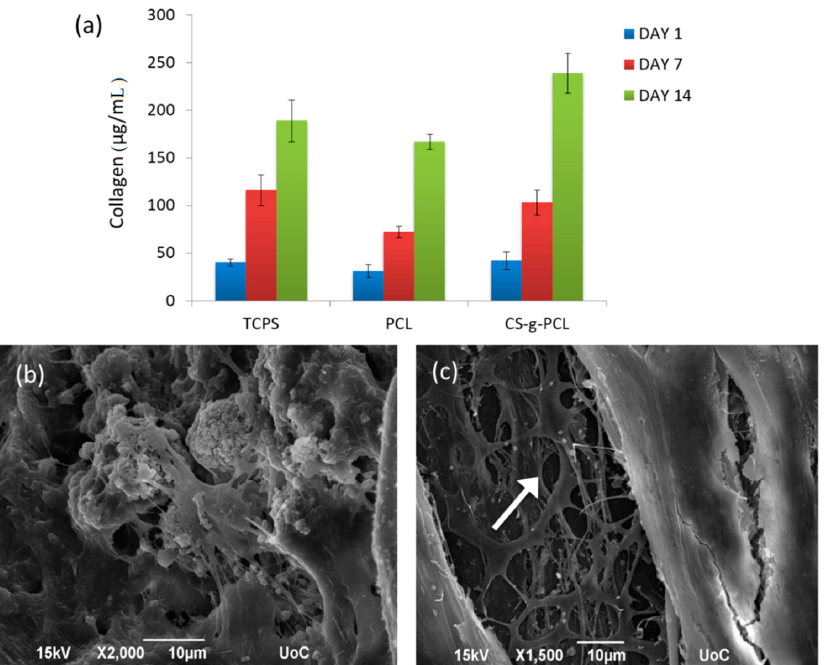
Figure 14. Extracellular collagen production of WJ-MSCs cultured on PCL and CS- g -PCL discs and the TCPS control for 1, 7, and 14 days ( a ). SEM images showing WJ-MSCs on CS- g -PCL discs after 1 ( b ) and 4 ( c ) weeks in culture. Increased levels of produced collagen are found on all surfaces after 14 days in culture compared to day 1, with the CS- g -PCL discs depicting the highest increase. After one week in culture, we observe a high number of cells infiltrated into the pores of the CS- g -PCL discs. After four weeks in culture, we observe successive degradation of the CS- g -PCL disc (white